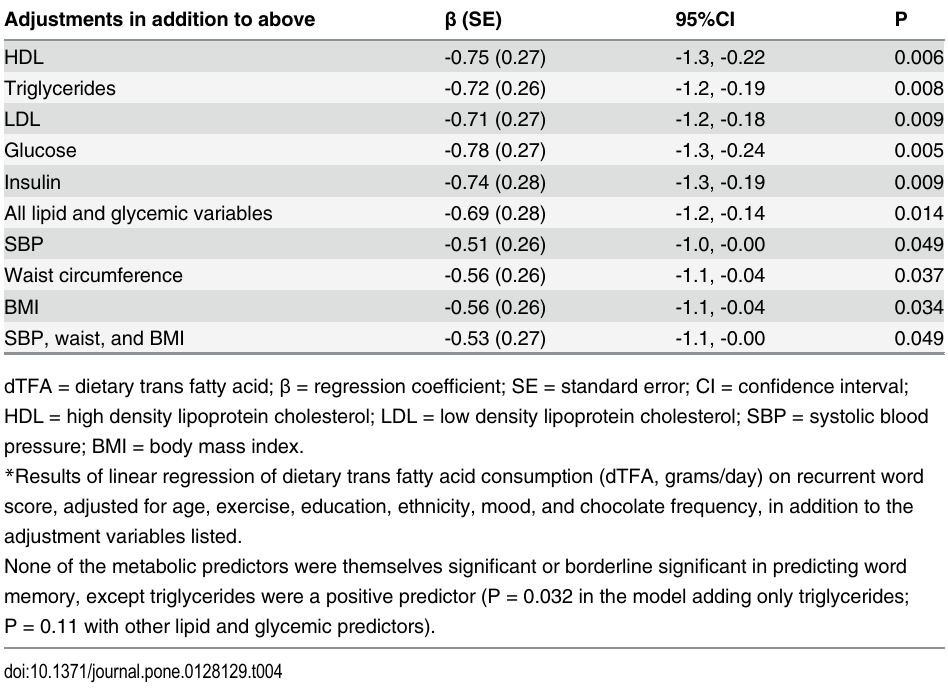
Table 4. Dietary Trans Fat Relation to Memory: Effect of Adding Potential Metabolic Mediators to Full Model (Men Age < 45) * . Adjustments in addition to